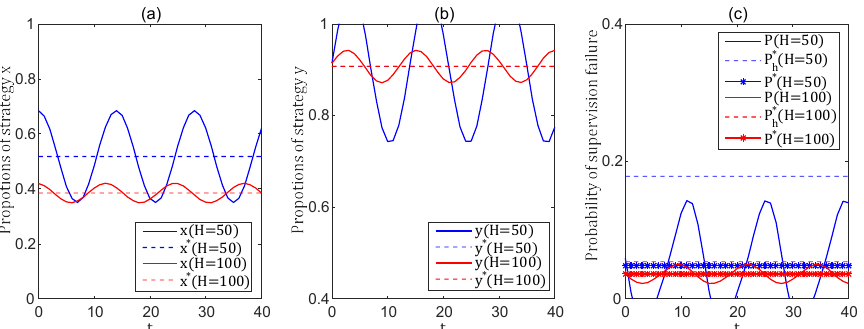
Figure 8. The influences of added benefits H on the periodical fluctuation. ( a ) The periodical fluctuation in proportions of strategies x with different added benefits H = 50 and H = 100. ( b ) The periodical fluctuation in proportions of strategies y with different added benefits H = 50 and H = 100. ( c ) The periodical fluctuation in the probability of supervision failure P with different added benefits H = 50 and H = 100. Through the above simulation results, the initial states and benefit–cost parameters are proven to be influential in food safety supervision. In order to improve the effectiveness of regulation and reduce the fluctuation in supervision, supervision institutions should discard historical path dependence and improve food safety standards appropriately. According to the actual implementation effects, supervision institutions should take corresponding reward